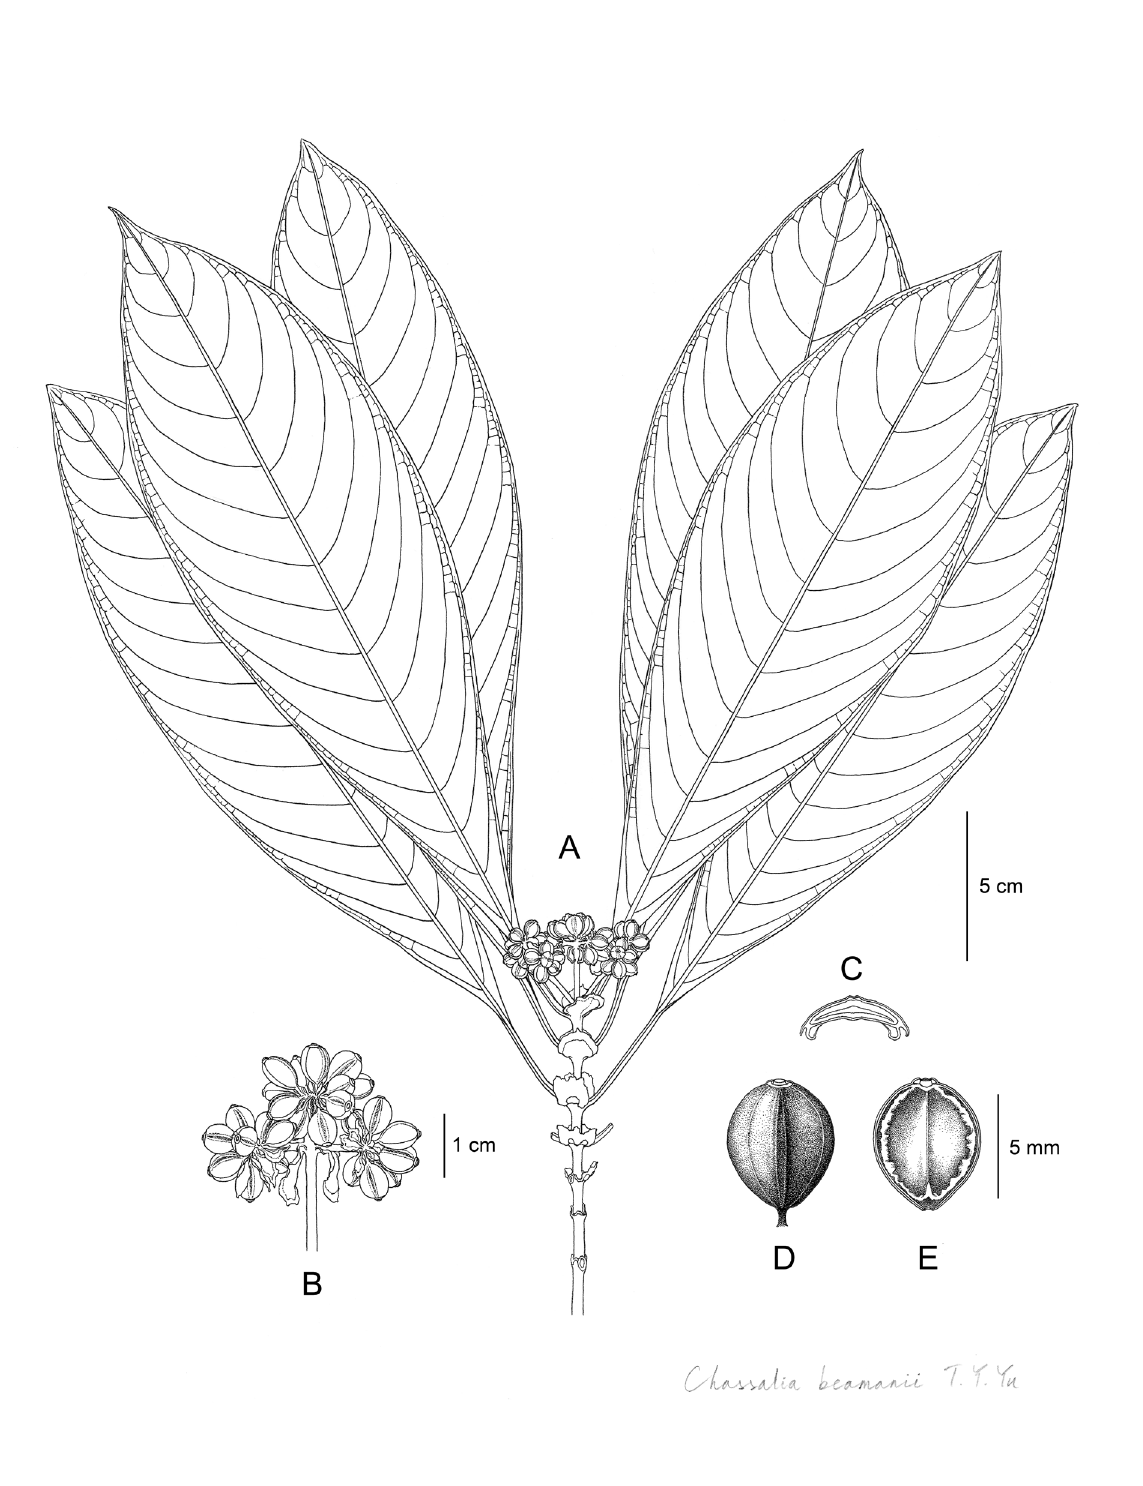
Fig. 6. Chassalia beamanii T.Y.Yu sp. nov. A . Flowering shoot. B . Infructescence. C . Pyrene transection. D . Dry fruit. E . Pyrene ventral surface. From John H. Beaman 10924 . Drawn by T.Y.